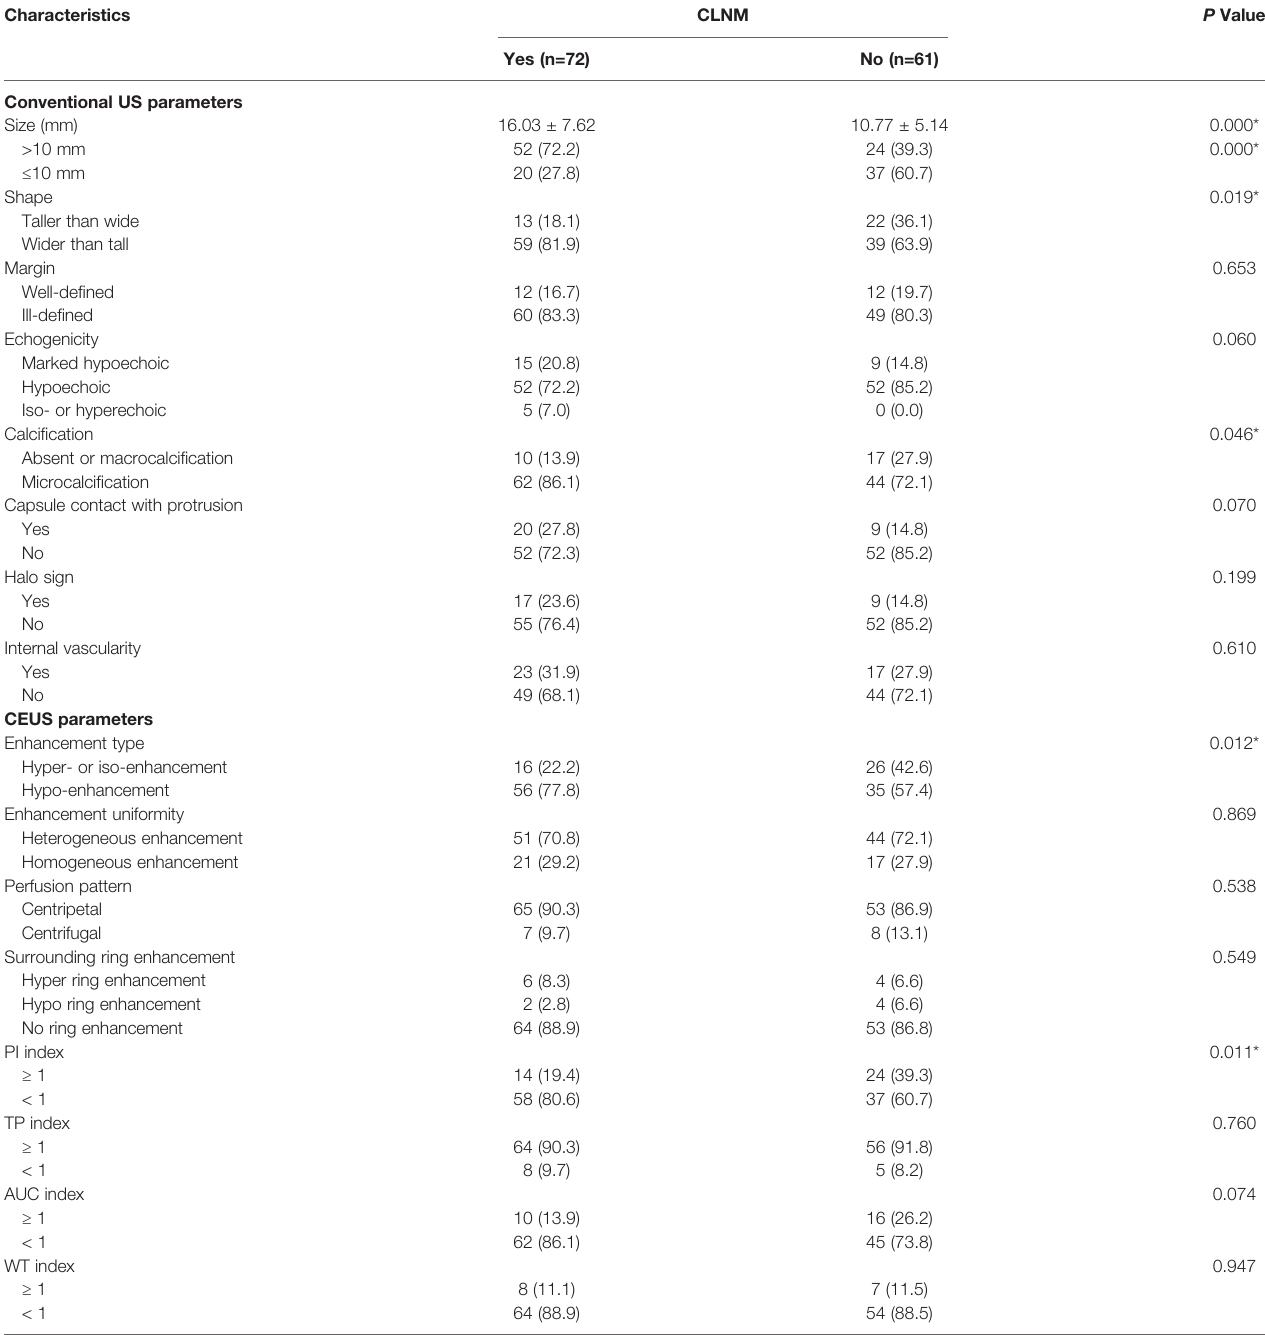
TABLE 2 | Ultrasonographic nodule characteristics of PTC patients coexisted with Hashimoto ’ s thyroiditis based on CLNM.